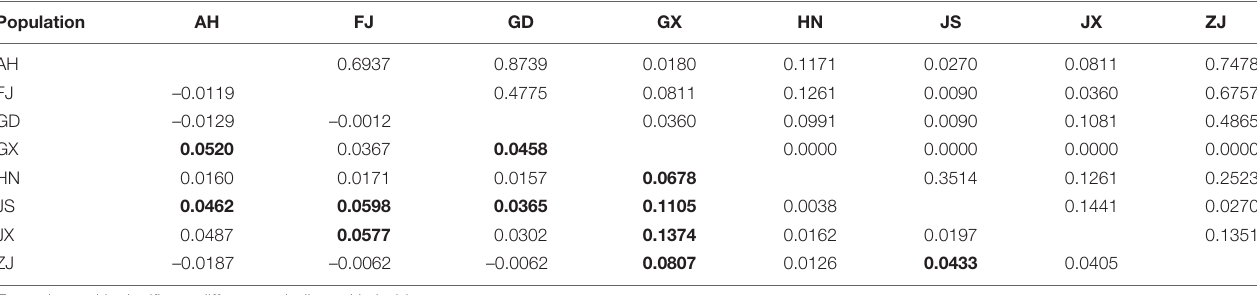
TABLE 5 | Pairwise population genetic differentiation (F ST , lower triangle) and P -values (upper triangle) among eight populations of Phyllotreta striolata based on haplotypes of the cox1 gene. Population